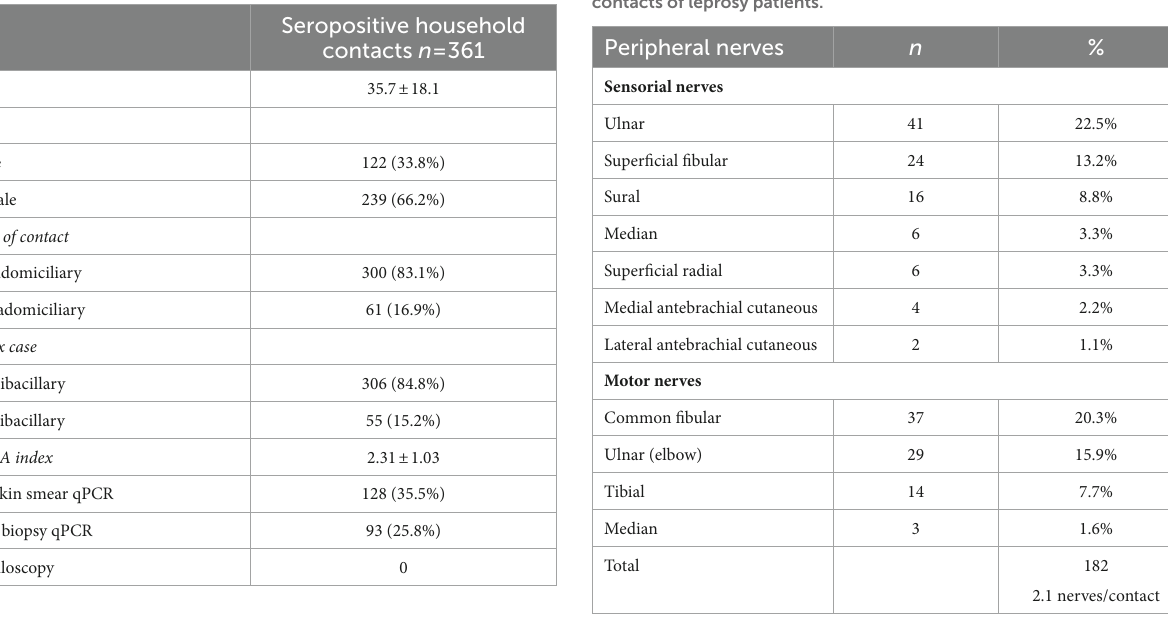
TABLE 1 Epidemiological, clinical, and laboratory characteristics among the household contacts of leprosy patients.